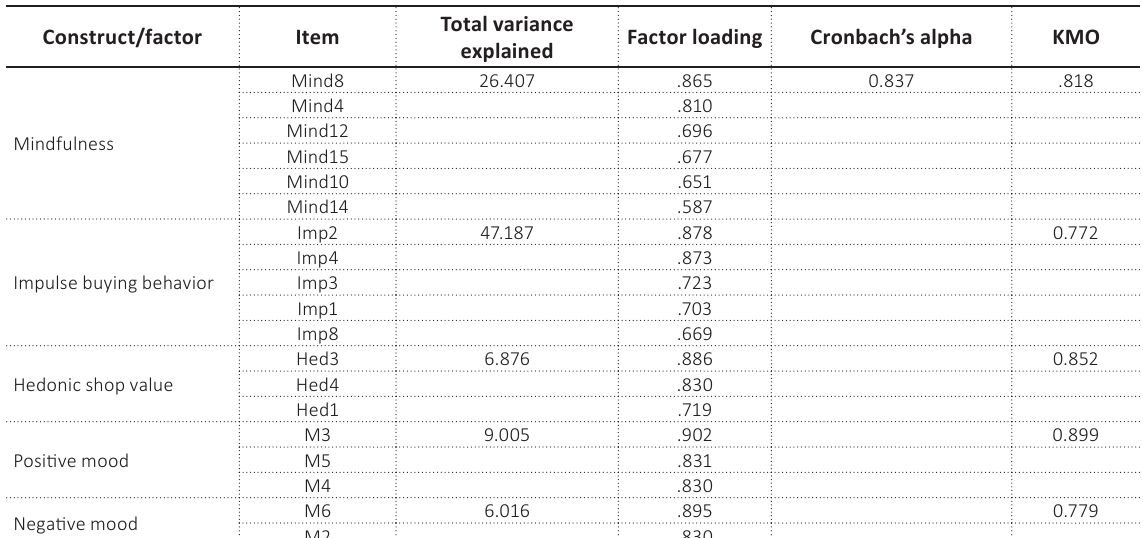
Table 3. Result of exploratory factor analysis and reliability